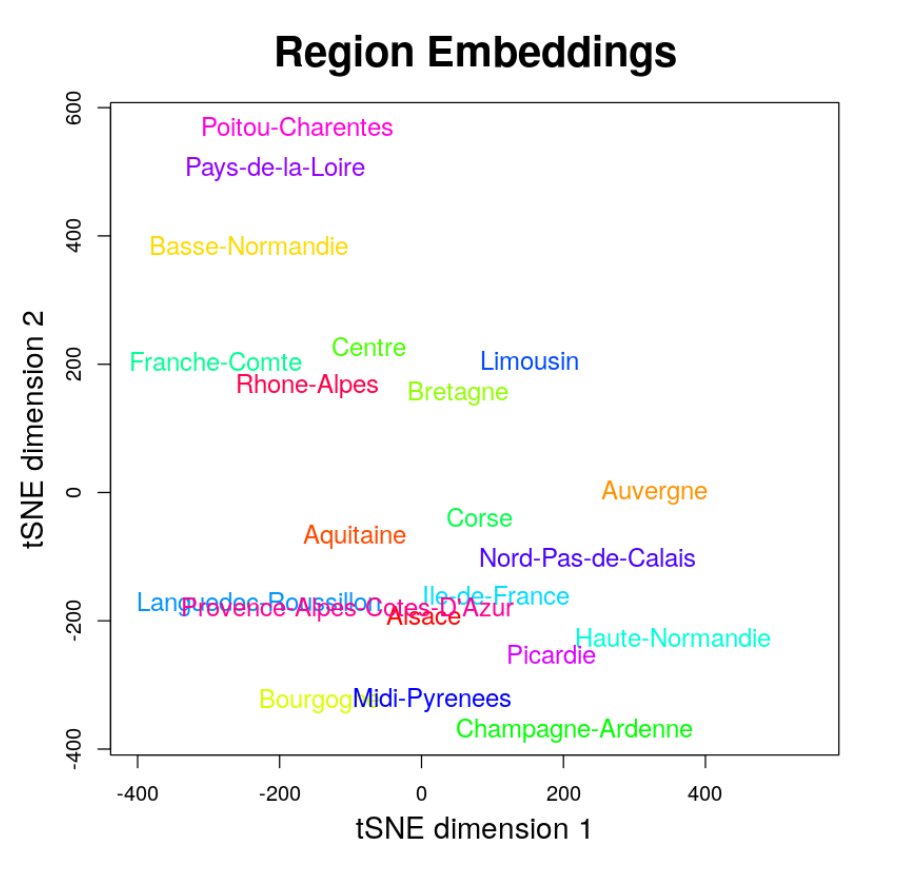
Figure 6. A tSNE visualization of the 10-dimensional embeddings for the different